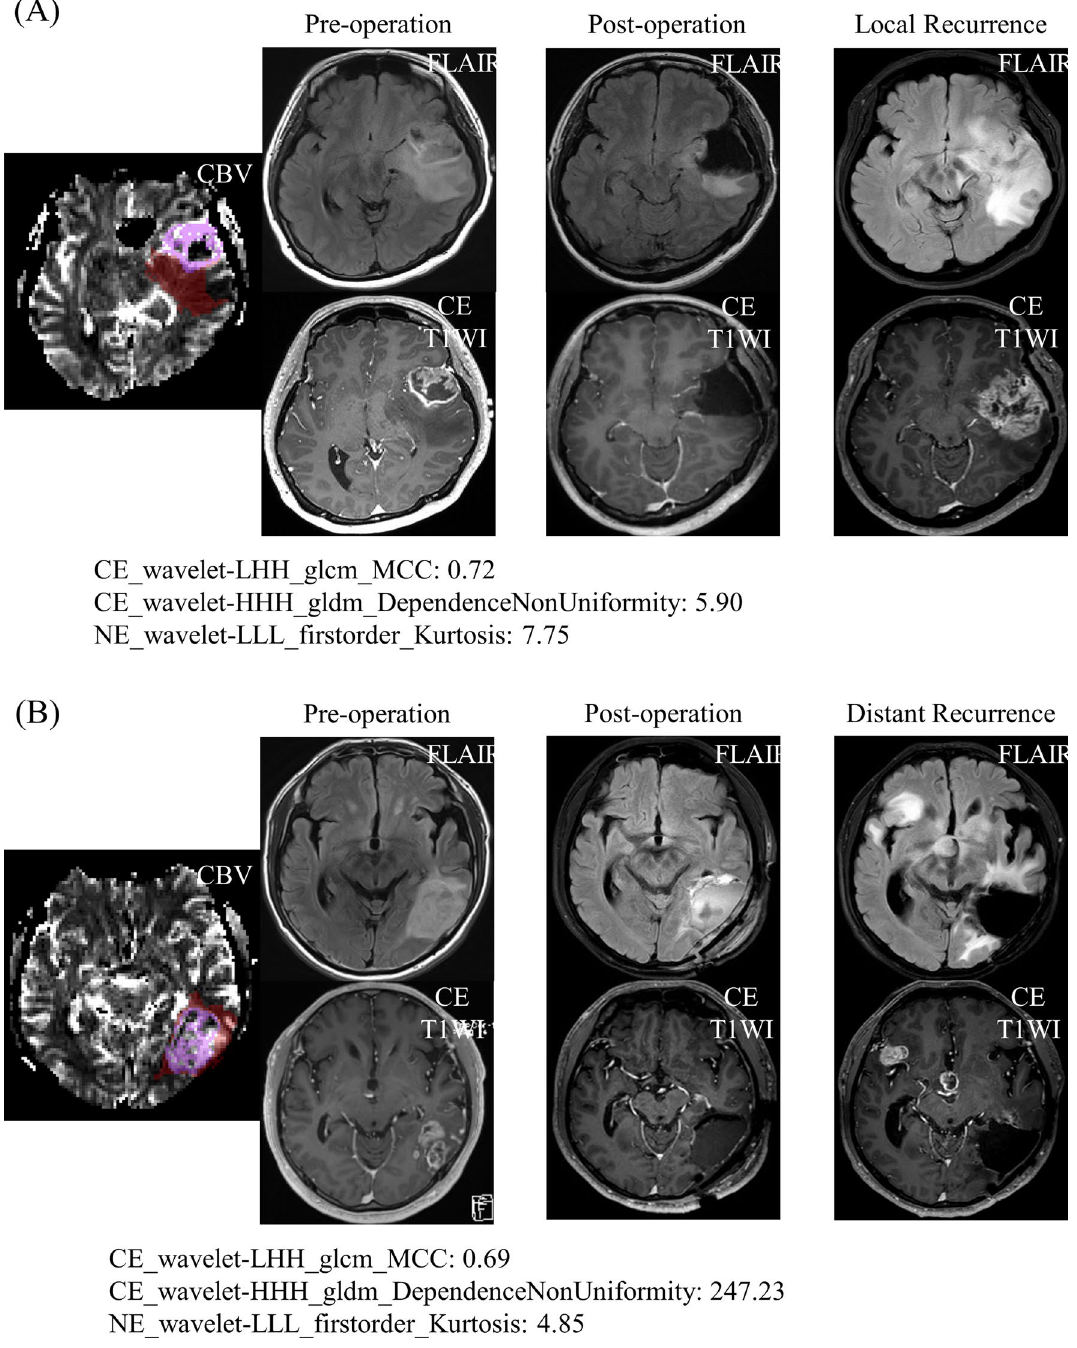
Figure 4. Representative glioblastoma cases with local recurrence ( A ) and with distant recurrence ( B ), respectively. ( A ) A glioblastoma patient who had early local recurrence (recurrence free surival = 12 months) after surgery. The contrast-enhanced glioblastoma with necrosis and high CBV was noted on pre-operative MRI, and total resection of the contrast-enhanced area was performed. In this patient, local recurrence was developed on follow-up MRI. ( B ) A glioblastoma patient who had early distant recurrence (recurrence free surival = 11 months) after surgery. The contrast-enhanced glioblastoma with necrosis and high CBV was noted on pre-operative MRI, and total resection of the contrast-enhanced area was performed. In this patient, distant recurrence was developed in the right sylvian fissure and suprasellar area. The distant recurrence case had a 42 times larger value of CE_wavelet_HHH_gldm_DependenceNonUniformity of CBV map, which represents the non-uniformity of gray level values, and thus heterogeneity of tumor, compared with the local recurrence case. Tumor ROI mask is overlaid on rCBV map (leftmost): contrast-enhanced tumor (CE) (purple), and nonenhanicng T2 hyperintense lesion (NE)